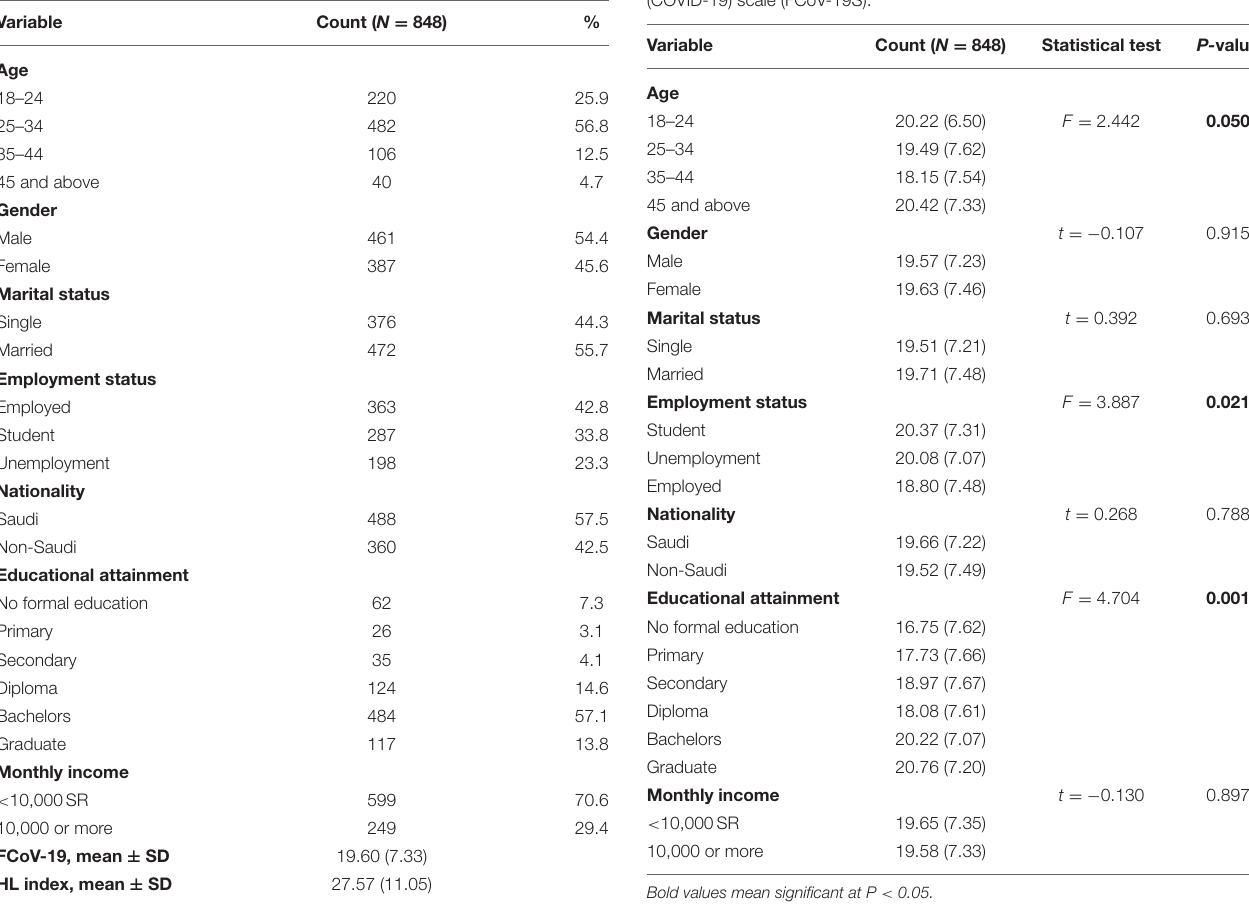
TABLE 1 | Demographic characteristics of the participants. TABLE 2 | Participants’ scores on the fear of Corona Virus Disease—2019